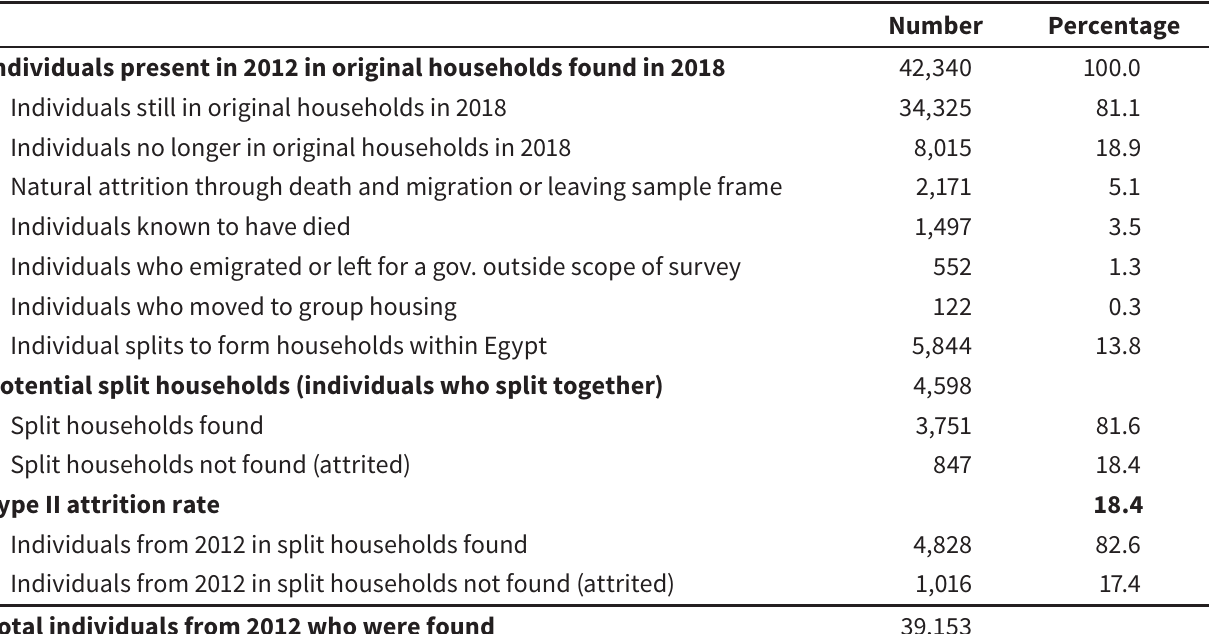
Number Percentage